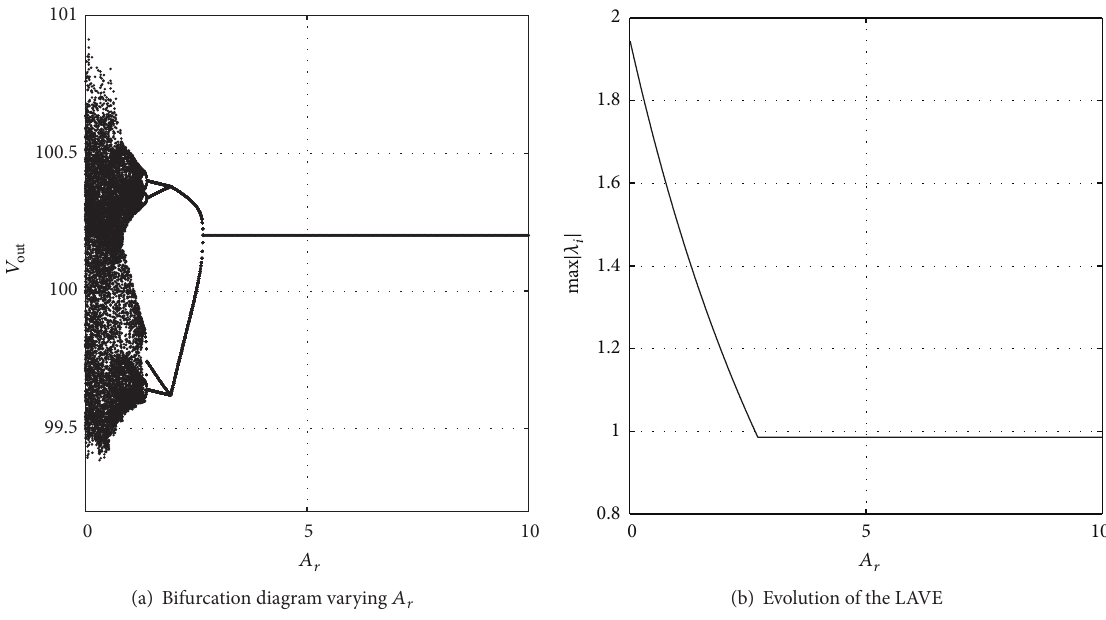
Figure 4: Steady state and stability of period-1 orbit as 𝐴 𝑟 varies in [0,10]